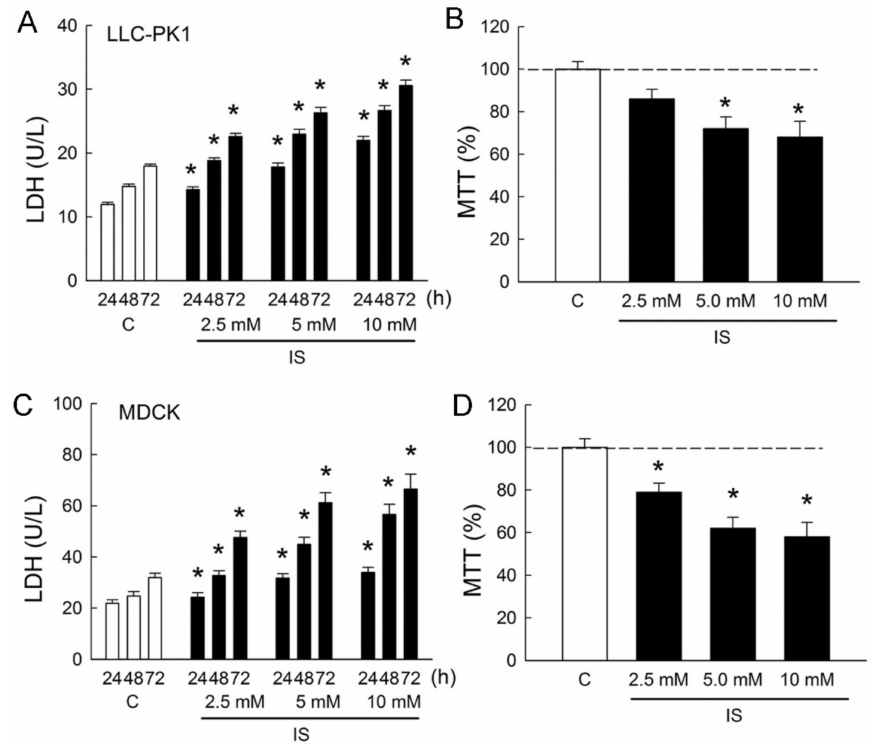
Figure 1. Indoxyl sulfate induces cytotoxicity in tubular cells. ( A , C ) Lilly Laboratories cell-porcine kidney 1 (LLC-PK 1 ) and Madin-Darby canine kidney cells (MDCK) were treated